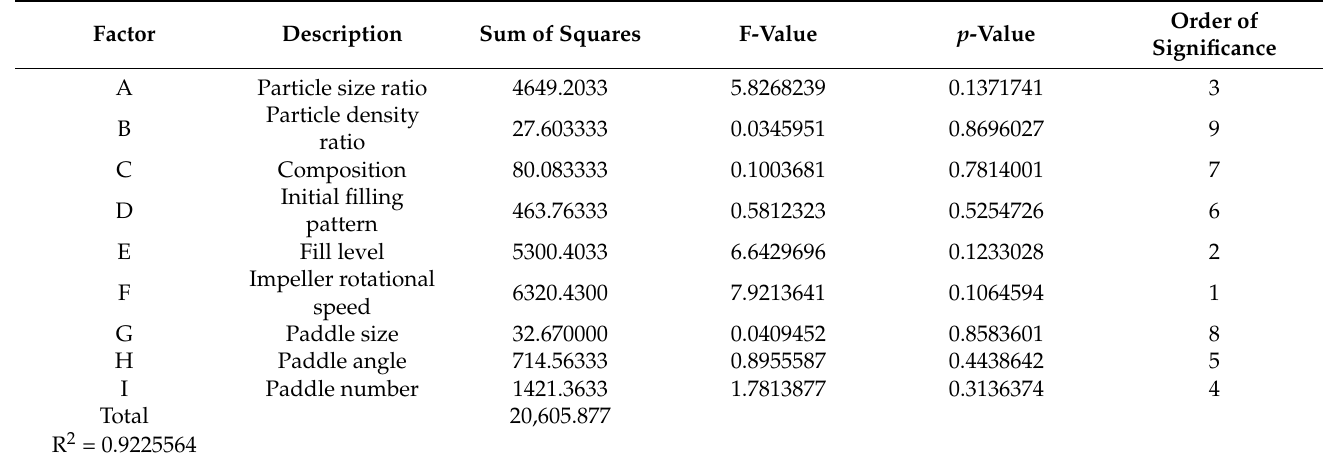
Figure 9. The main effect of factors on KPI 2 mixing time.